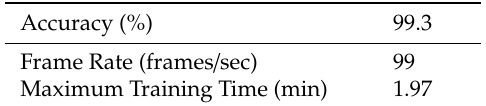
Table 3. Summary of the implemented system’s evaluation